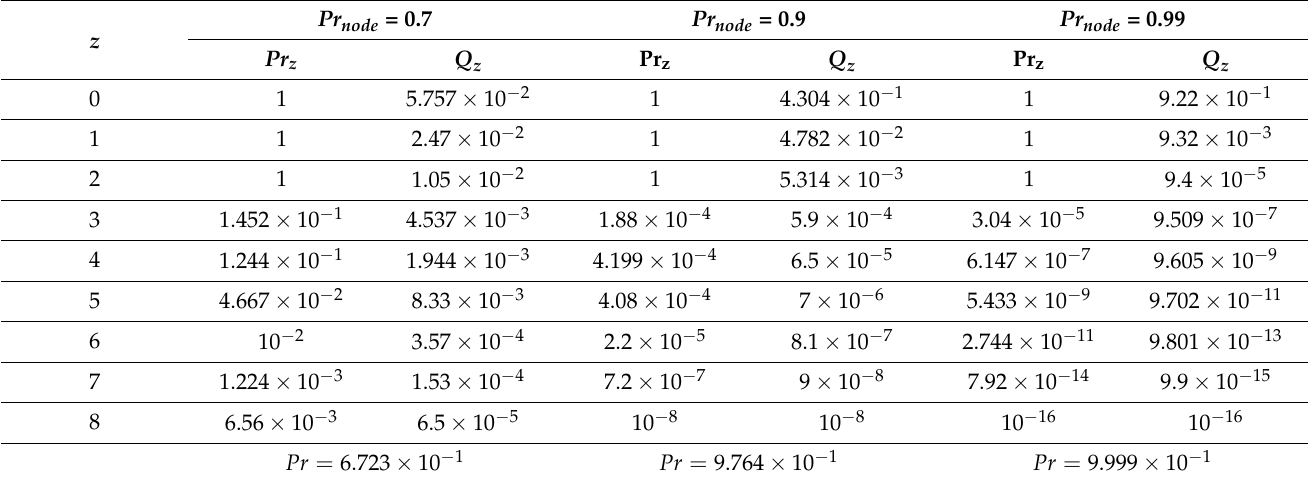
Table 1. Probability of secure data transmission Pr z with z intercepted nodes for the different probability of the node attack